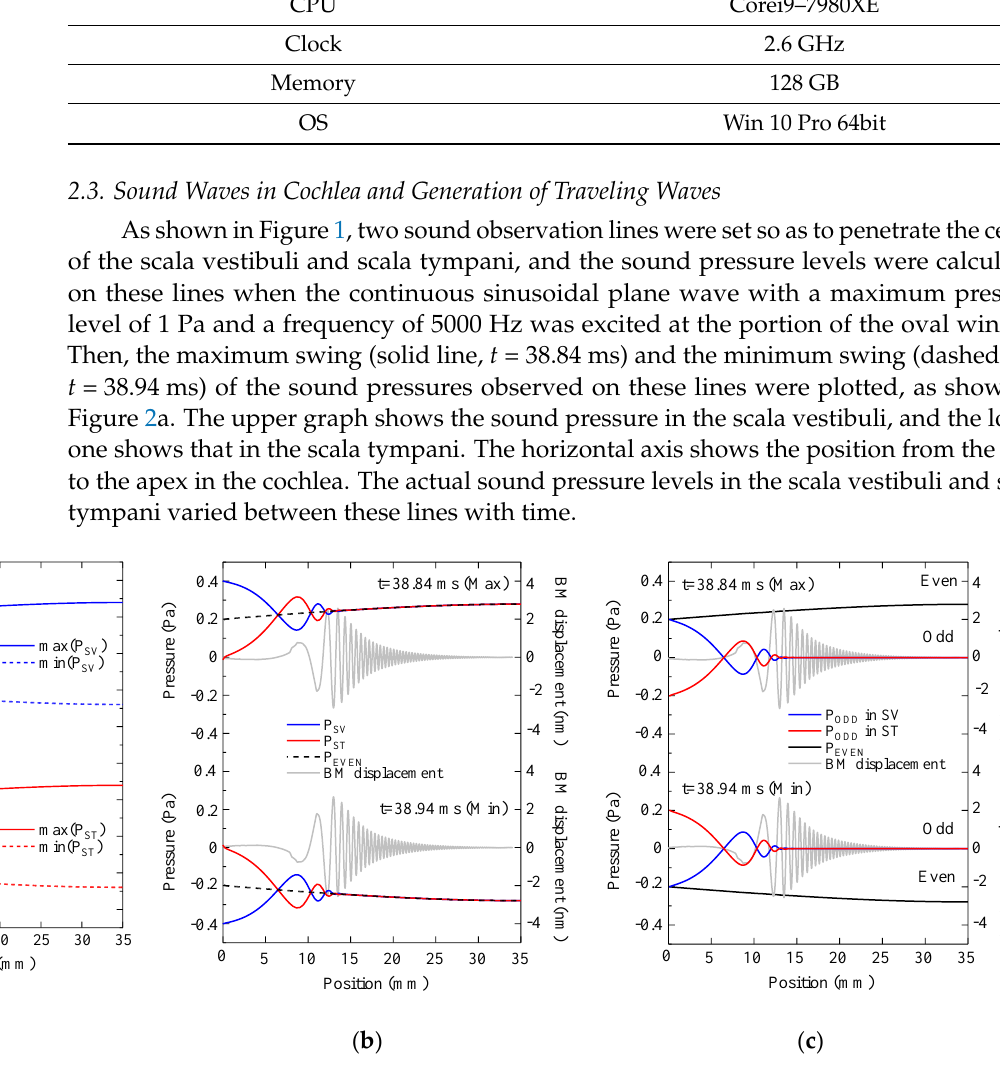
Figure 2. Evaluation of sound pressure levels in the scala vestibuli and scala tympani, and the displacement of the basilar membrane when a continuous sinusoidal plane wave with a pressure level of 1 Pa and a frequency of 5000 Hz was excited at the oval window. The horizontal axis shows the position in the cochlea. The observation times t = 38.84 ms and 38.94 ms were chosen by trial and error so that the waveform swing P EVEN became the maximum or the minimum after the waveform reached a steady state. ( a ) Maximum (solid line, t = 38.84 ms) and minimum (dashed line, t = 38.94 ms) sound pressure levels in the scala vestibuli (in blue) and scala tympani (in red). ( b ) Sound pressure levels in the scala vestibule (in blue) and scala tympani (in red), and the displacement of the basilar membrane (in light gray). The upper and lower graphs present the simulation results observed at t = 38.84 ms and t = 38.94 ms, respectively. ( c ) Sound pressure levels of the even and odd modes, and the displacement of the basilar membrane (in light gray), observed at t = 38.84 ms (the upper graph) and t = 38.94 ms (the lower graph). The sound pressure levels of the odd modes in the scala vestibuli and scala tympani are shown in blue and in red, respectively.